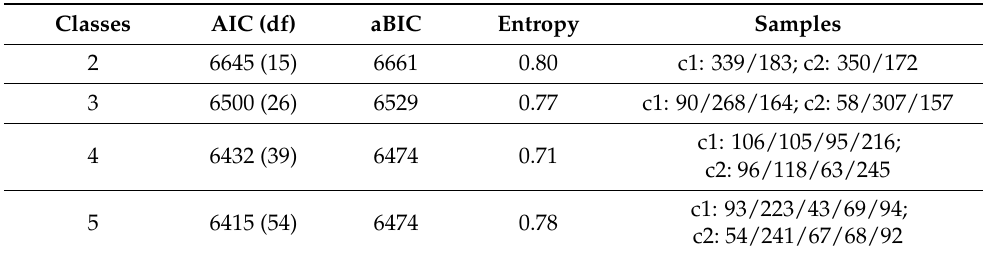
Table 3. Latent transition analysis model fit statistics to select longitudinally the number of classes of resilience at